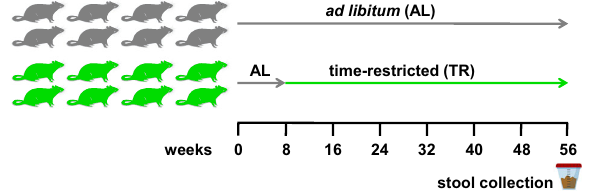
Fig. 1 Experimental design. Schematic representation of the experimental design of the study.